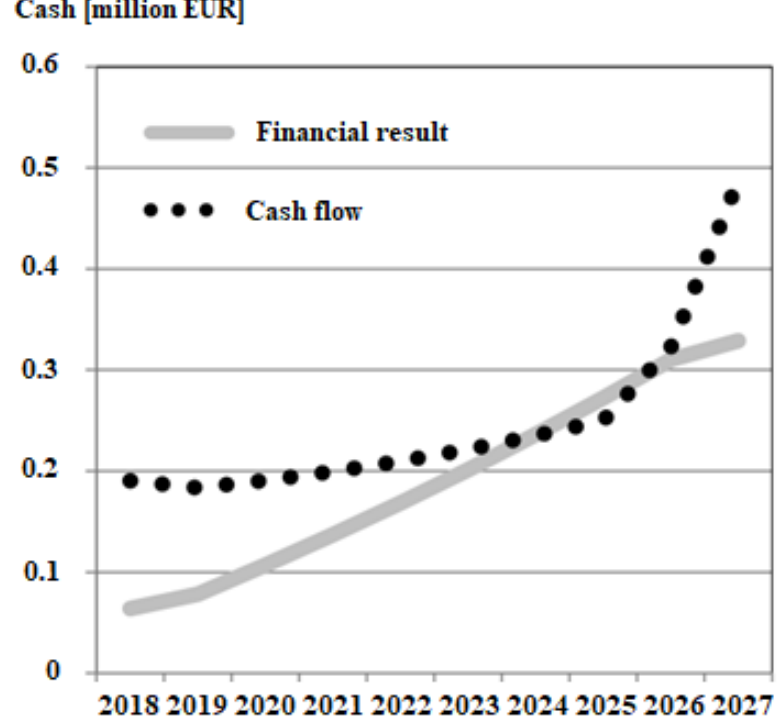
Figure 2. Financial result and cash flow [55].